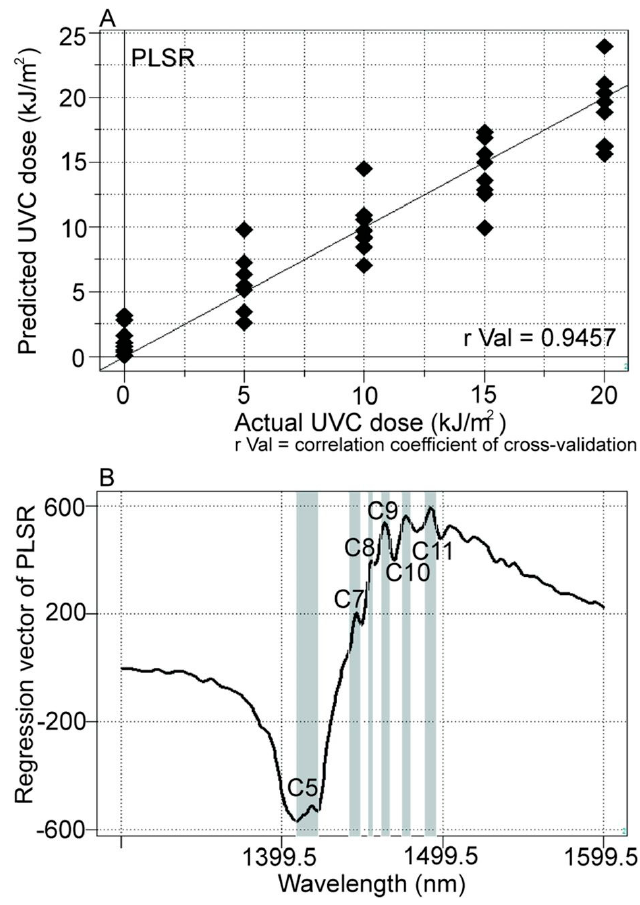
Figure 6. PLSR model for prediction of UV irradiation dose: ( A ) Y-fit curve showing relationship between actual and predicted values; ( B ) regression vector of PLSR model showing water absorbance bands affected by UV light perturbation [48].